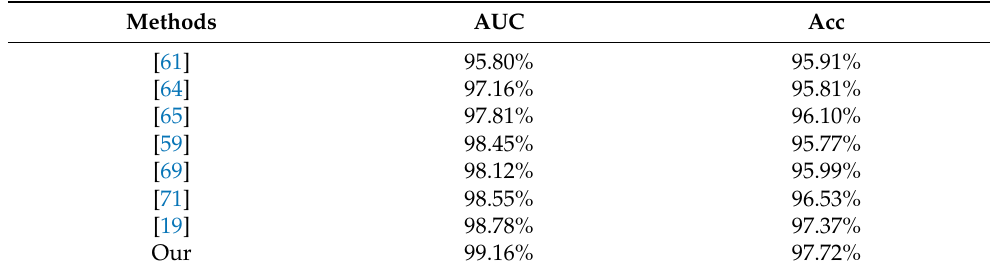
Table 9. A comparison with the state-of-the-art vessel segmentation on the CHASE_DB1